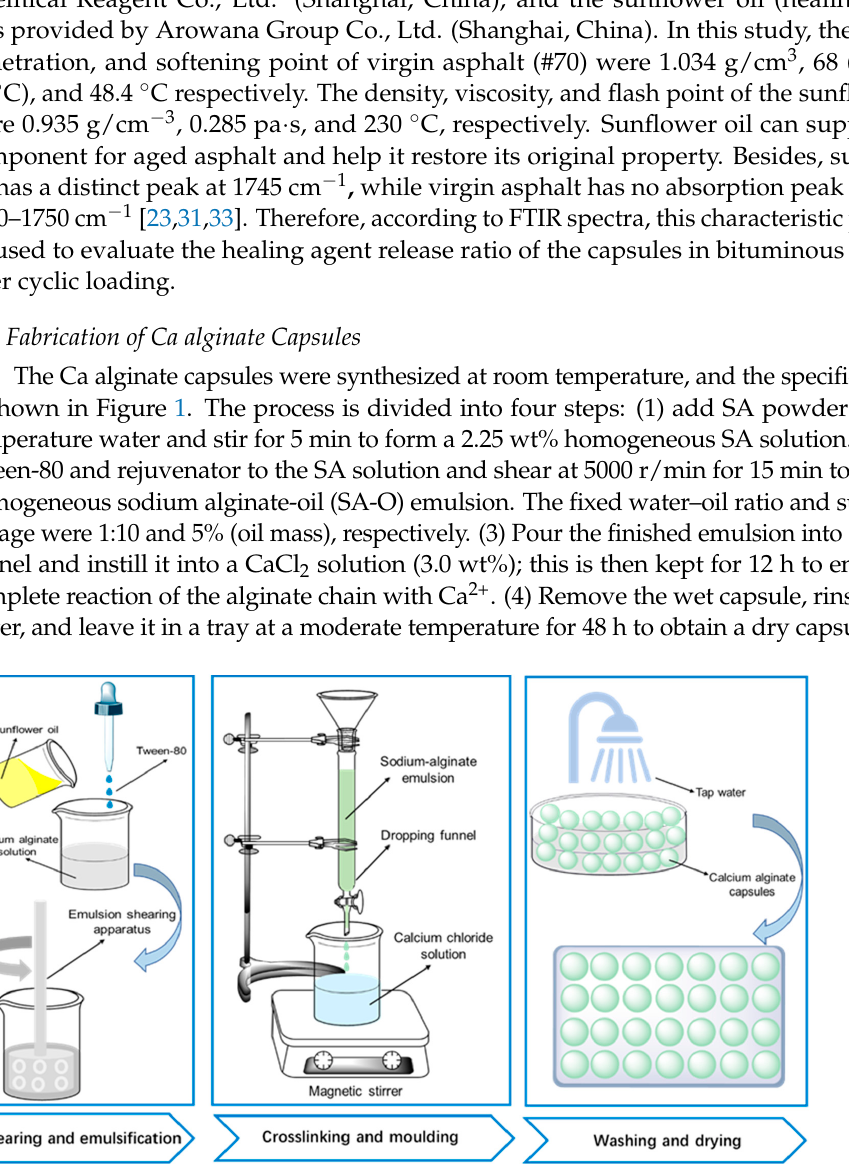
Figure 1. Preparation procedure of Calcium alginate